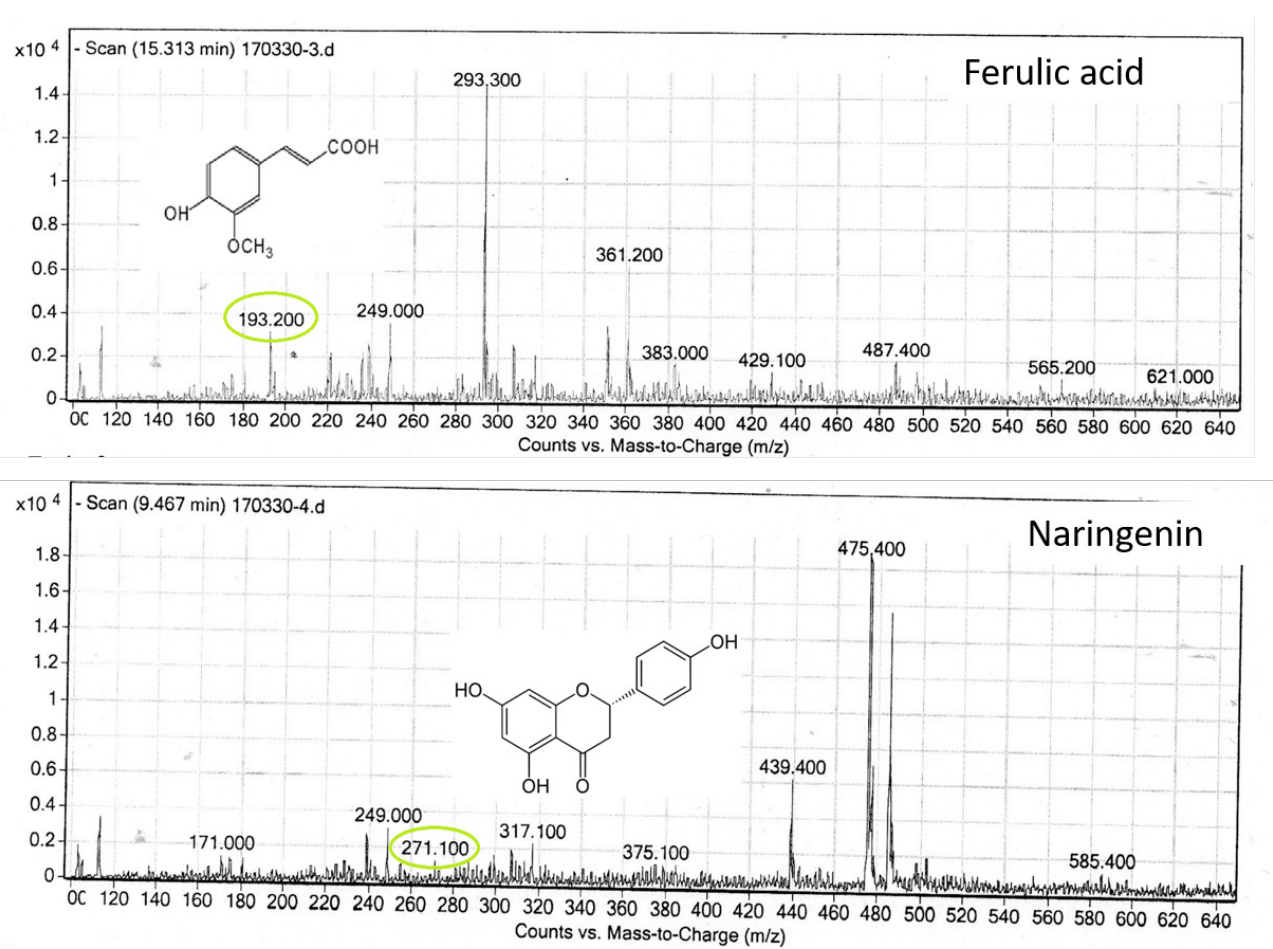
FIGURE 3 - Chromatograms showing some of the substances identified in the extracts based on their mass/charge ratio